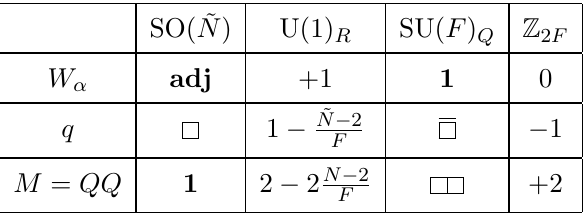
Table 8 . Quantum numbers of fields in the magnetic SO(